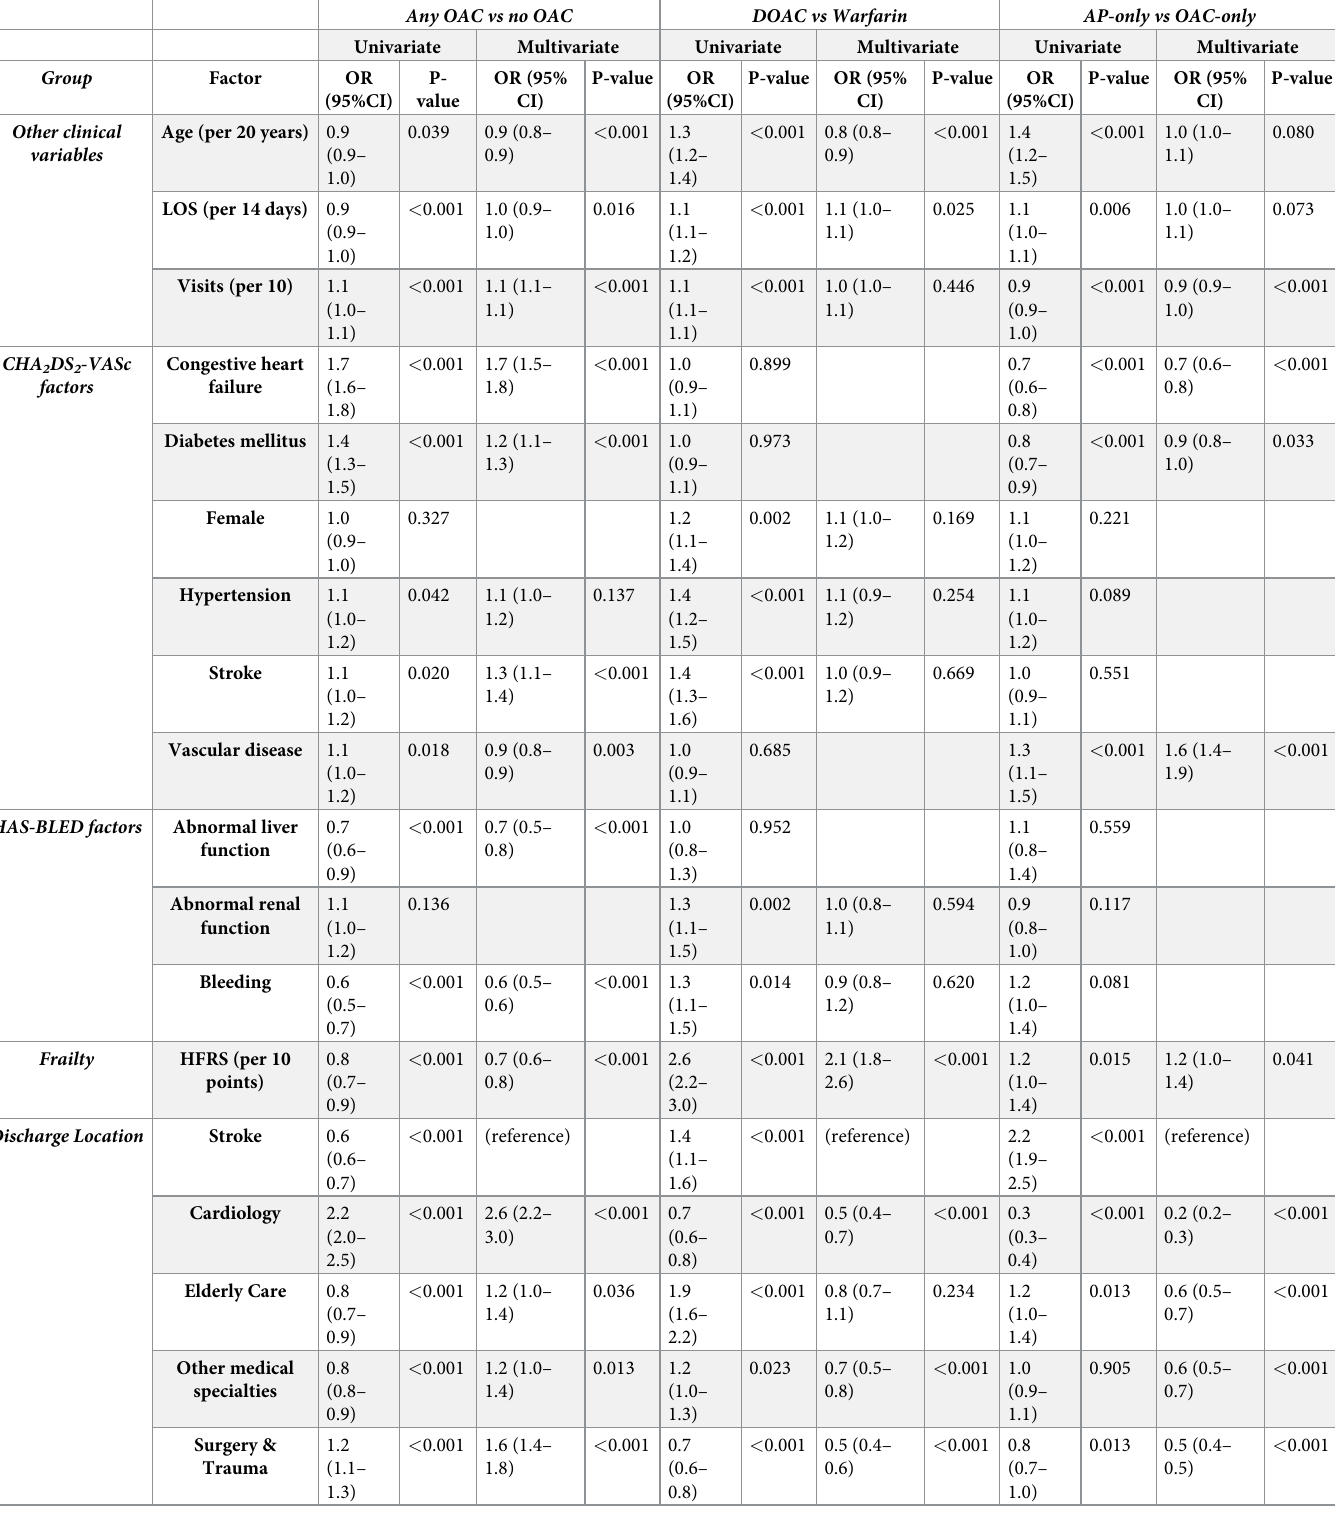
Table 4. Univariate and multivariate logistic regression for factors associated with antithrombotic drug prescribing at most recent discharge for patients with CHA 2 DS 2 -VASc �